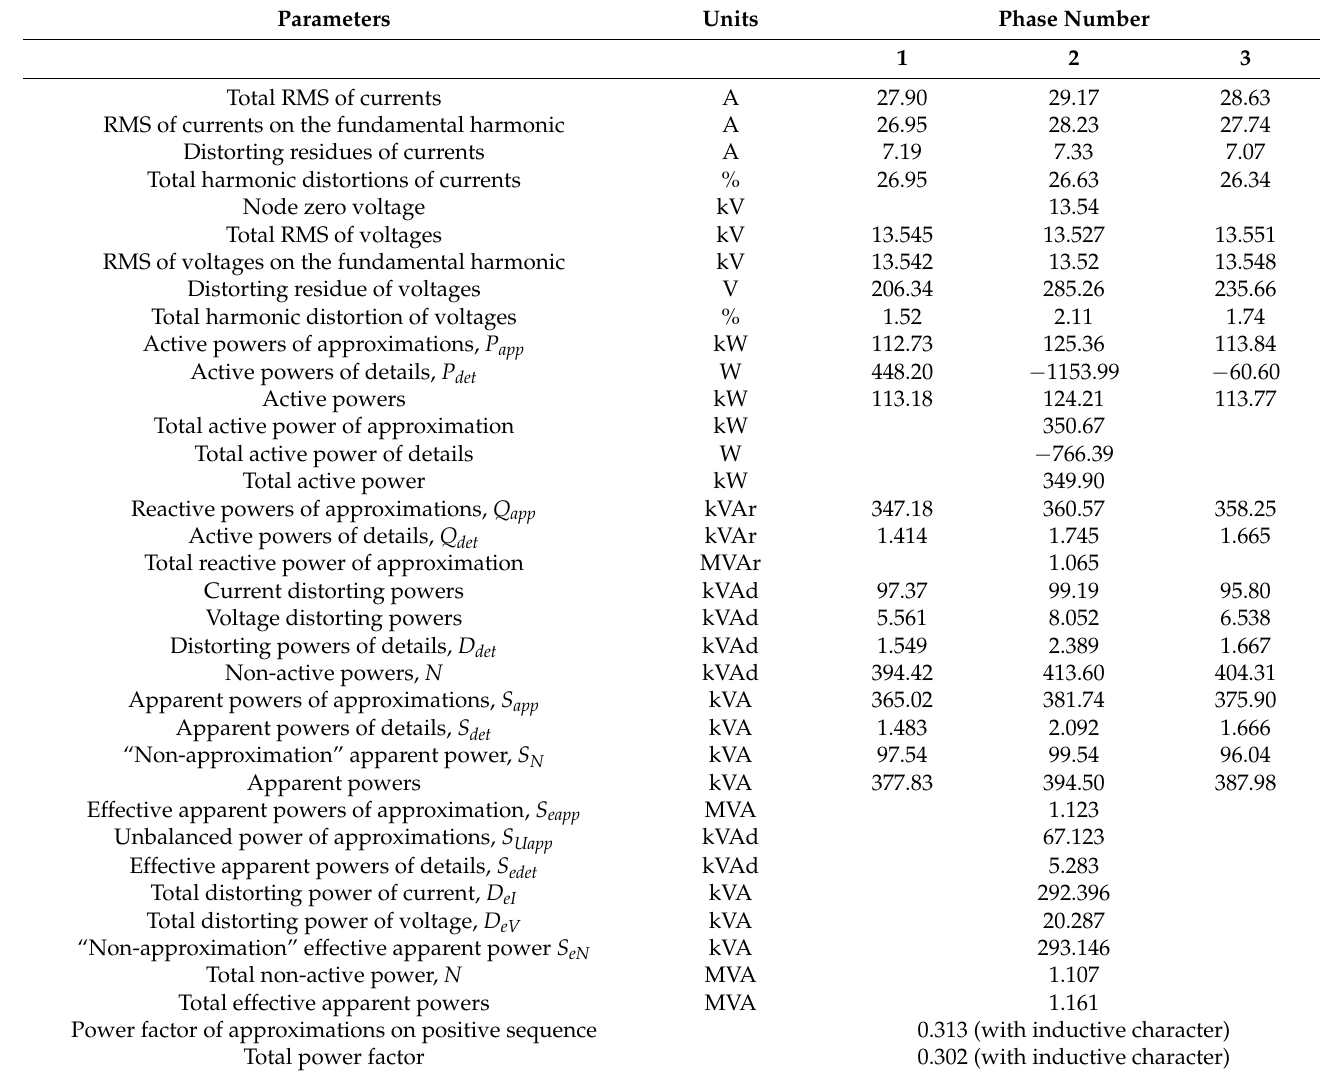
Table 5. Power quality indices, the powers and power factor using DWT and the third theory, second case study.